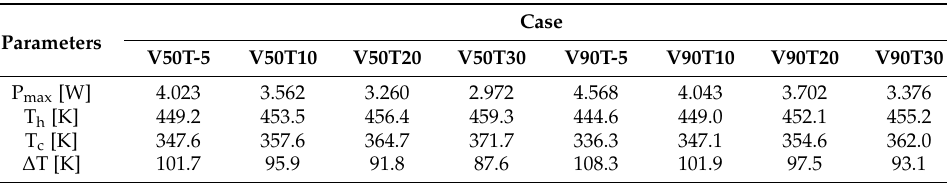
Table 4. Results for cold side heat exchanger using air as cooling fluid.